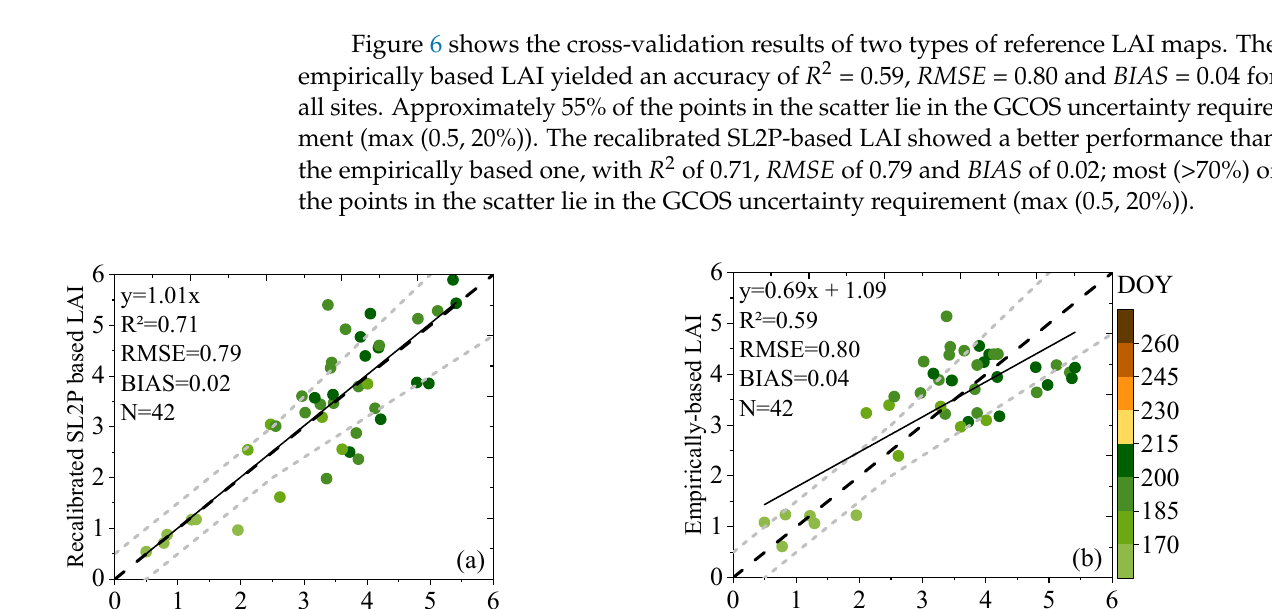
Figure 5. Comparison between the Sentinel-2 LAI and LAINet for ( a ) the entire time period (from day of year (DOY) 152 to 263) and ( b ) for the green-up period (from DOY 152 to 211). The black dashed line indicates 1:1 line, and solid line indicates linear regressions between Sentinel-2 LAI and LAINet. The gray dashed lines show the Global Climate Observ- ing System uncertainty requirements for LAI (max (0.5, 20%)).